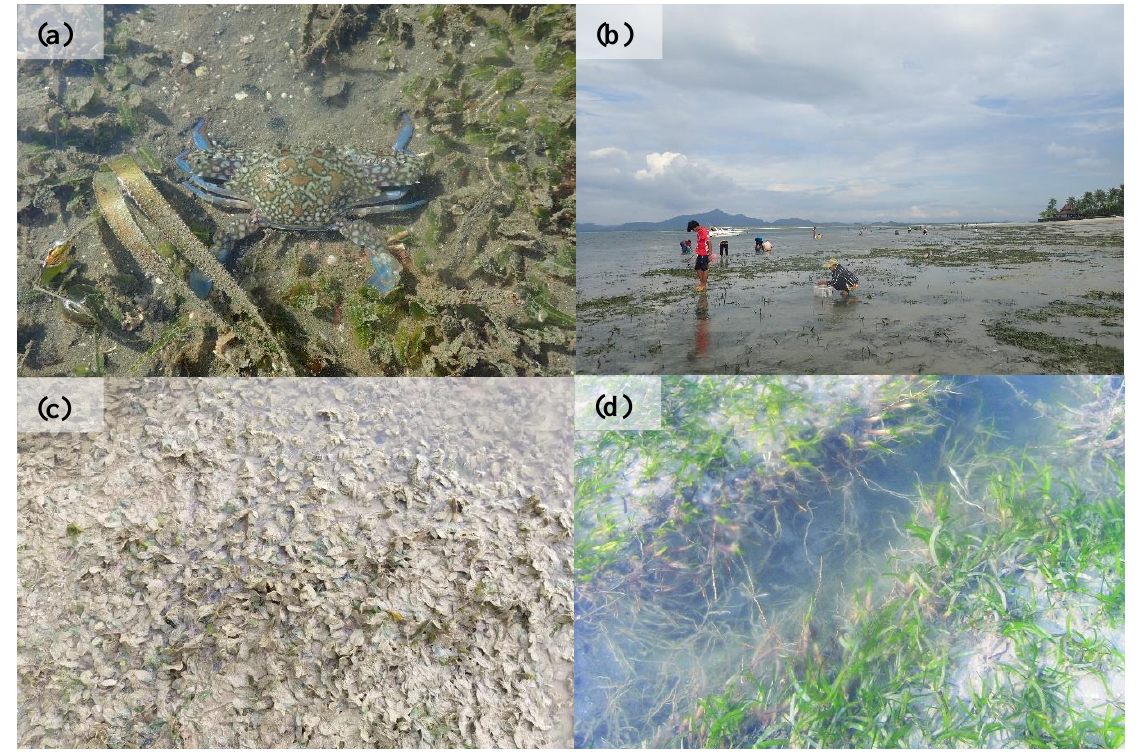
Figure 2. Some important ES and VU of seagrass meadows presented in this study: ( a ) shelter for marine animals; ( b ) importance of seagrass meadows for local fisheries; ( c ) sediment cover on seagrass leaves; and ( d ) scar on seagrass beds from boat accident.